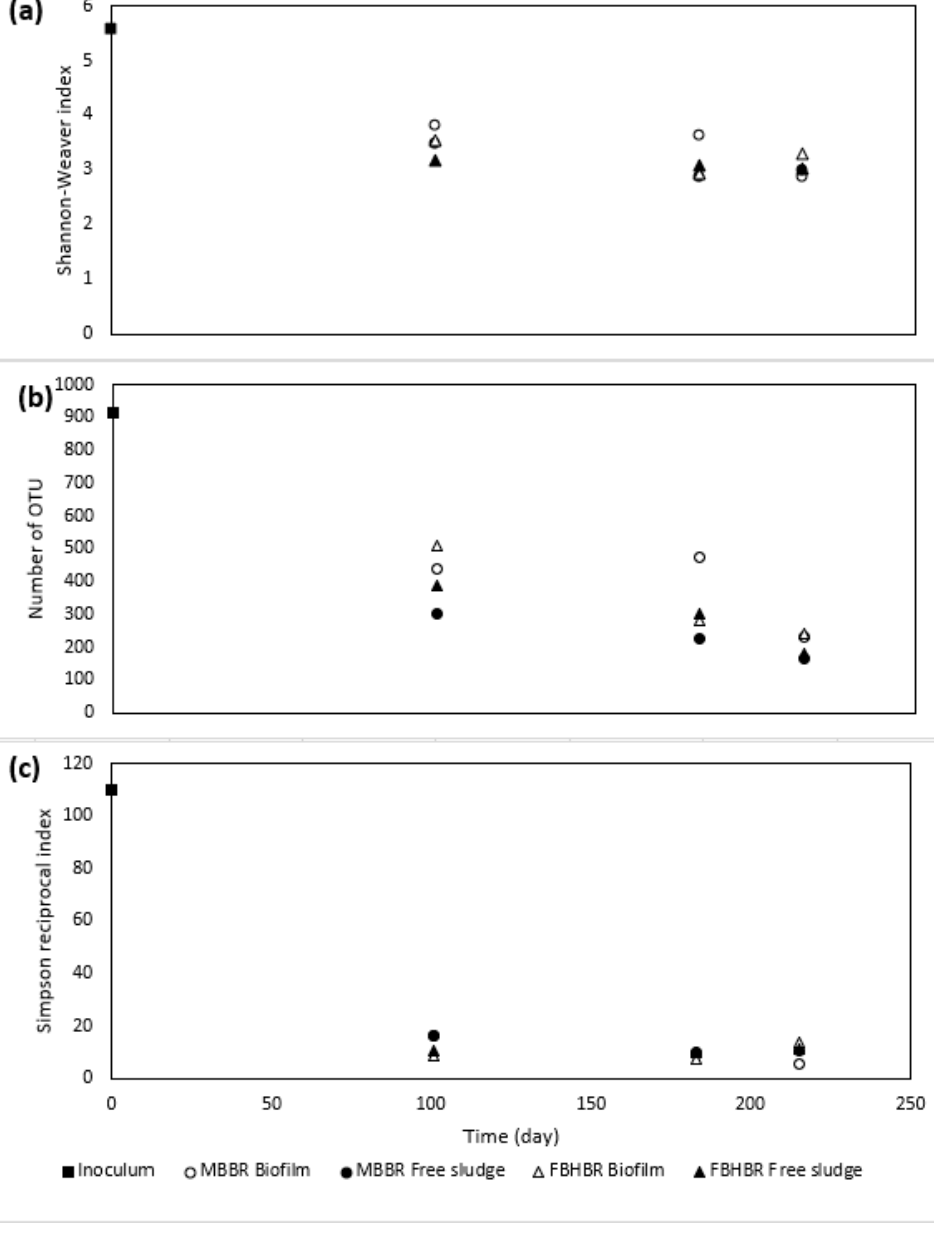
Figure 6. Evolution of bacterial diversity indices in both MBBR and FBHBR: Shannon Weaver index ( a ), number of OTU ( b ) and Simspon reciprocal index ( c ).